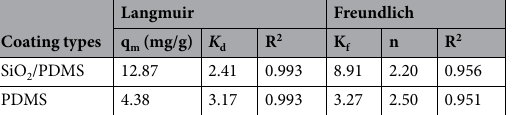
Table 2. Langmuir and Freundlich constants for PhOH adsorption on PDMS or SiO 2 /PDMS. Notes: q m (mg/g) presents max adsorption amount per unit mass; K d , K f and n mean physical parameters in two adsorption isotherm models.